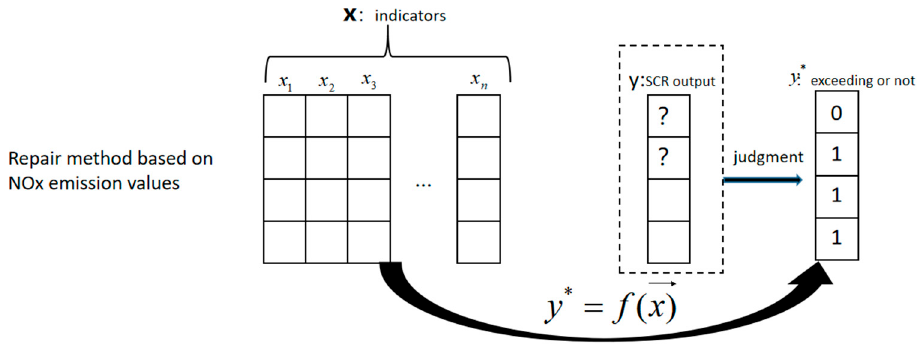
Figure 3. Identification of excessive emissions by prediction, based on the data rather than the SCR output (“?” indicates missing values, “1” and “0” denote excessive emission or not, and y * is a binary variable indicating whether emission exceeds).